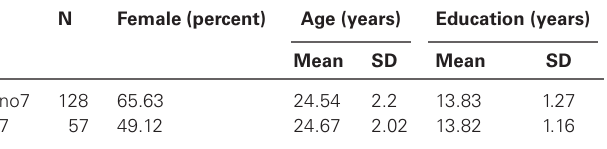
Table 1 | Age, gender and education data for the DRD4 7R genotype, SD: standard deviation. N Female (percent)